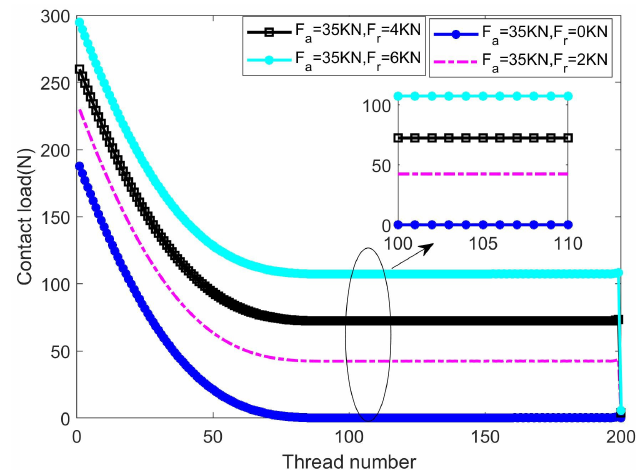
Figure 19. The effects of different radial loads in case